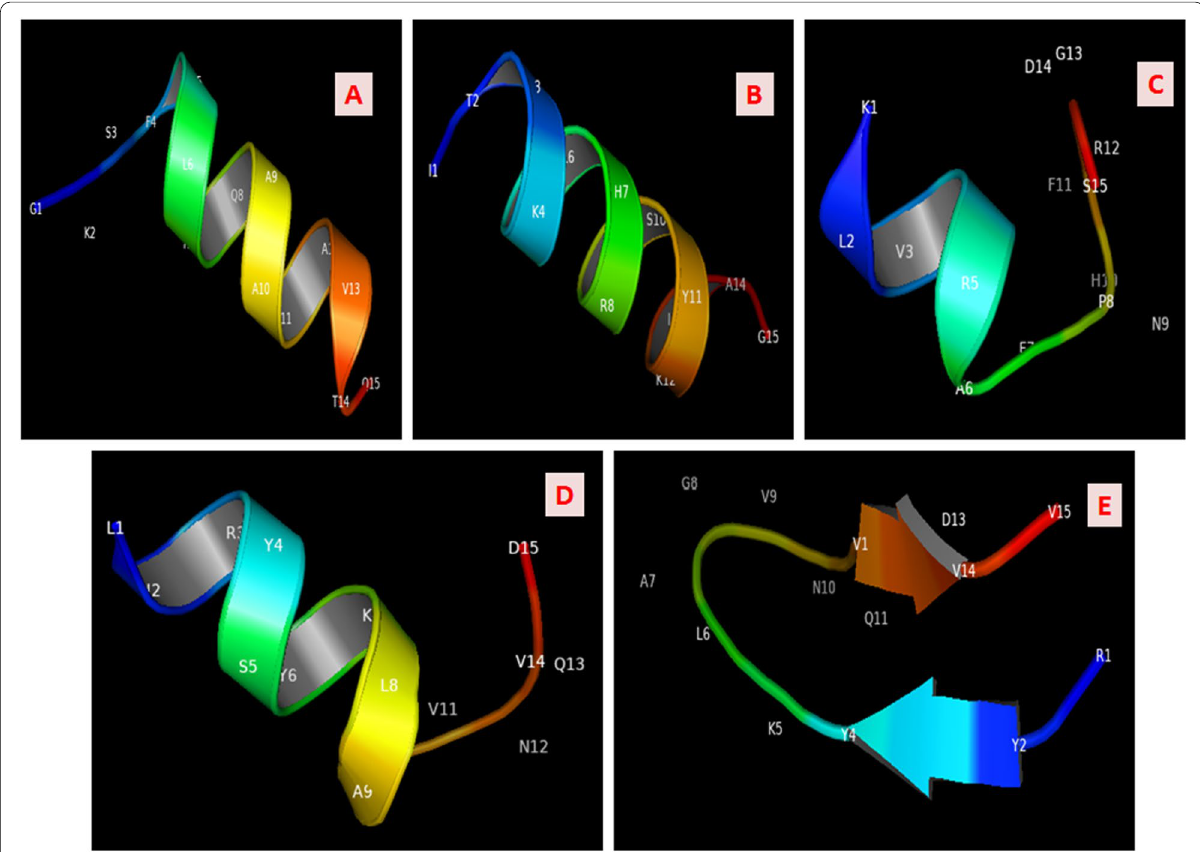
Fig. 2 Epitopes 3D structures. A GKSFELNQAARAVTQ. B ITLKLLHRYSYKLAG. C KLVLRAFPNHFRGDS. D LHRYSYKLAGVNQVD. E RYSYKLAGVNQVDVV